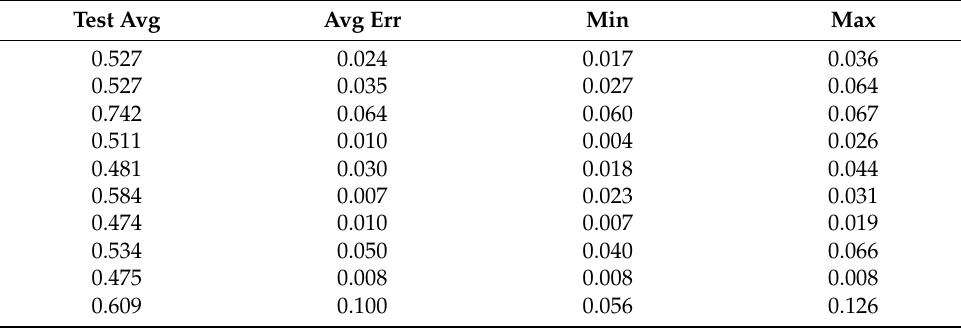
Table A67. Set 1, trials 41–50 data (single 0.5 PR